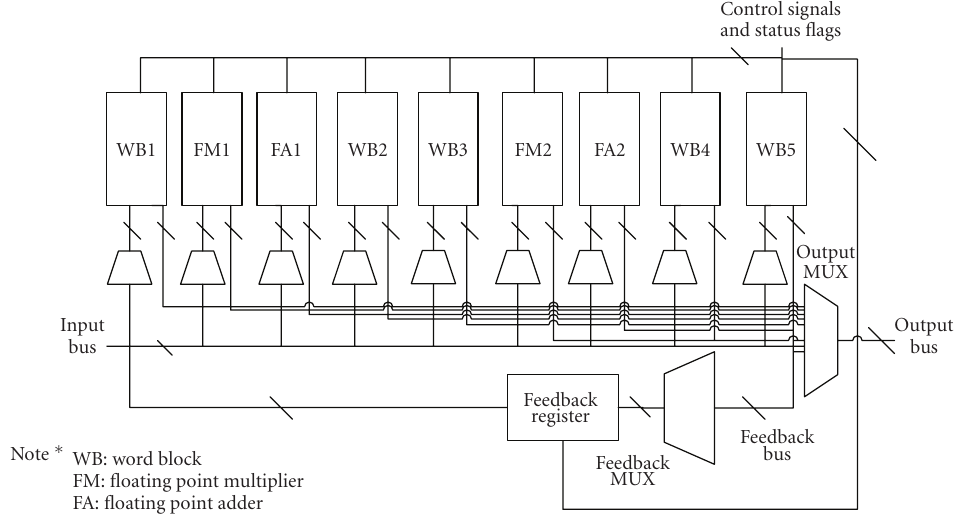
Figure 2: Coarse-grained unit modelled in this paper.